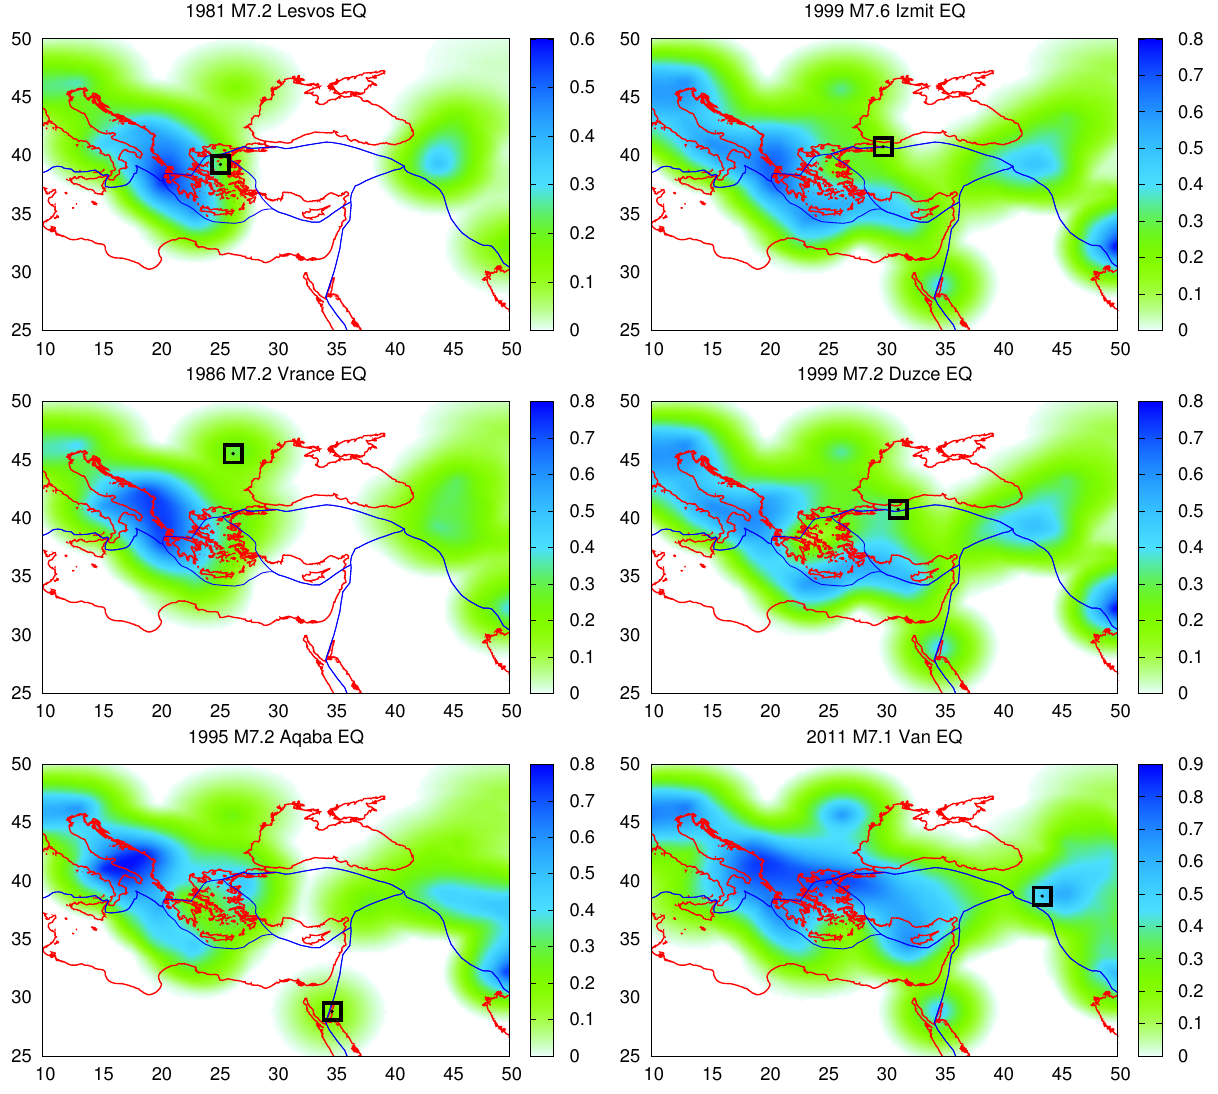
Figure 4. Maps of the area N 50 E 50 together with the plate boundaries (blue) according to [132] depicting by color scale the 25 10 (cid:104) EPS (cid:105) for R = 250 km at the time of the observation of β min [115], see the (red) open circles of Figure 2, before all the mainshocks of M ≥ 7.1 within the area A 6 , see the red rectangle of Figure 1. The EQ epicenters are shown by the (black) open squares in each case. For the 1999 M7.2 Düzce EQ, the local β 120 minimum observed on 8 September 1999 (see Figure 2) was used. The latter minimum was not as deep as those identified in Reference [115]; see the discussion there about Düzce EQ, which was followed by the deadly 7 September 1999 M6.0 Athens EQ and was discussed later